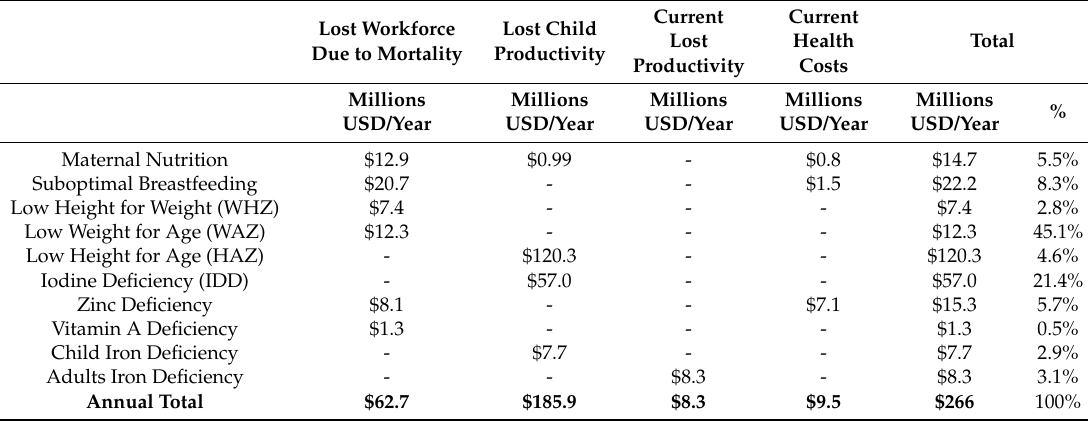
Table 6. Summary Economic Consequences for all Indicators’ Net Present Value at 3% (Adjusted for Multiple Risks in million